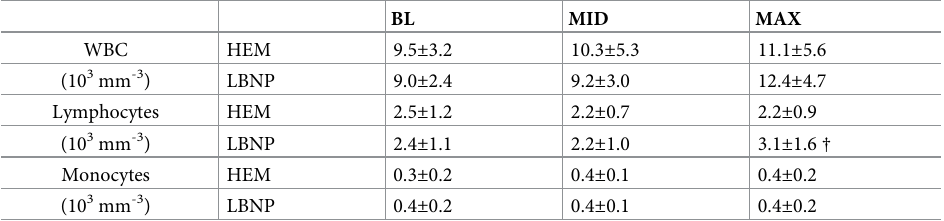
Table 1. Cell counts before and during blood removal (HEM) and during lower body negative pressure